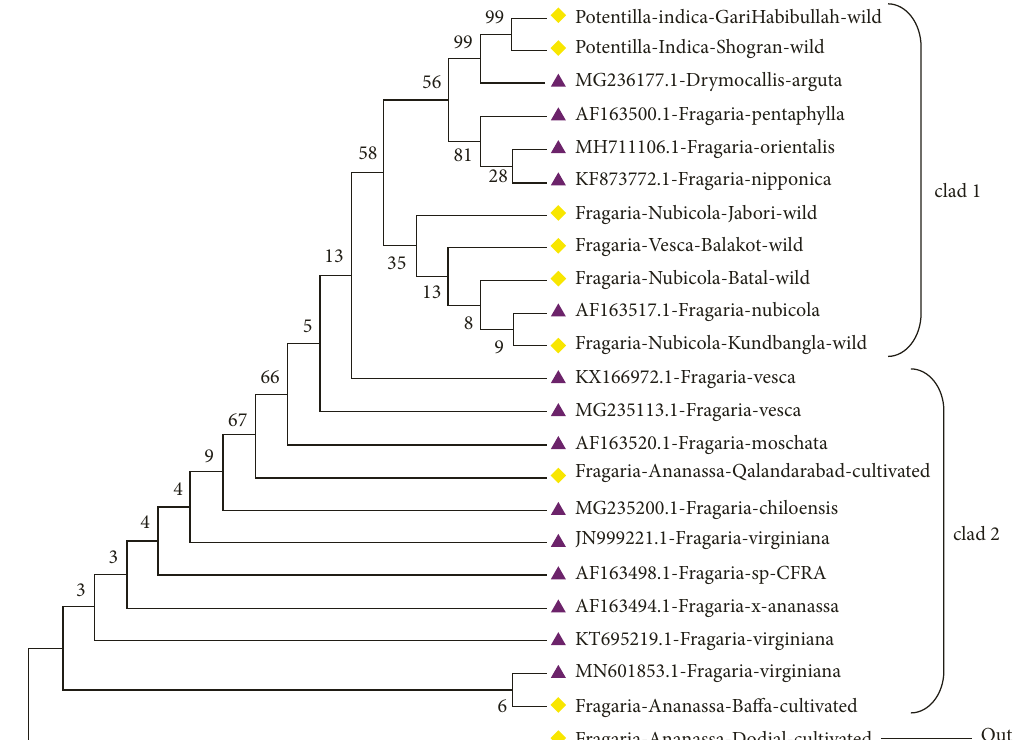
Figure 13: Phylogenetic tree of selected Fragaria sequences of the ITS2 marker with reference sequences by using the maximum parsimony